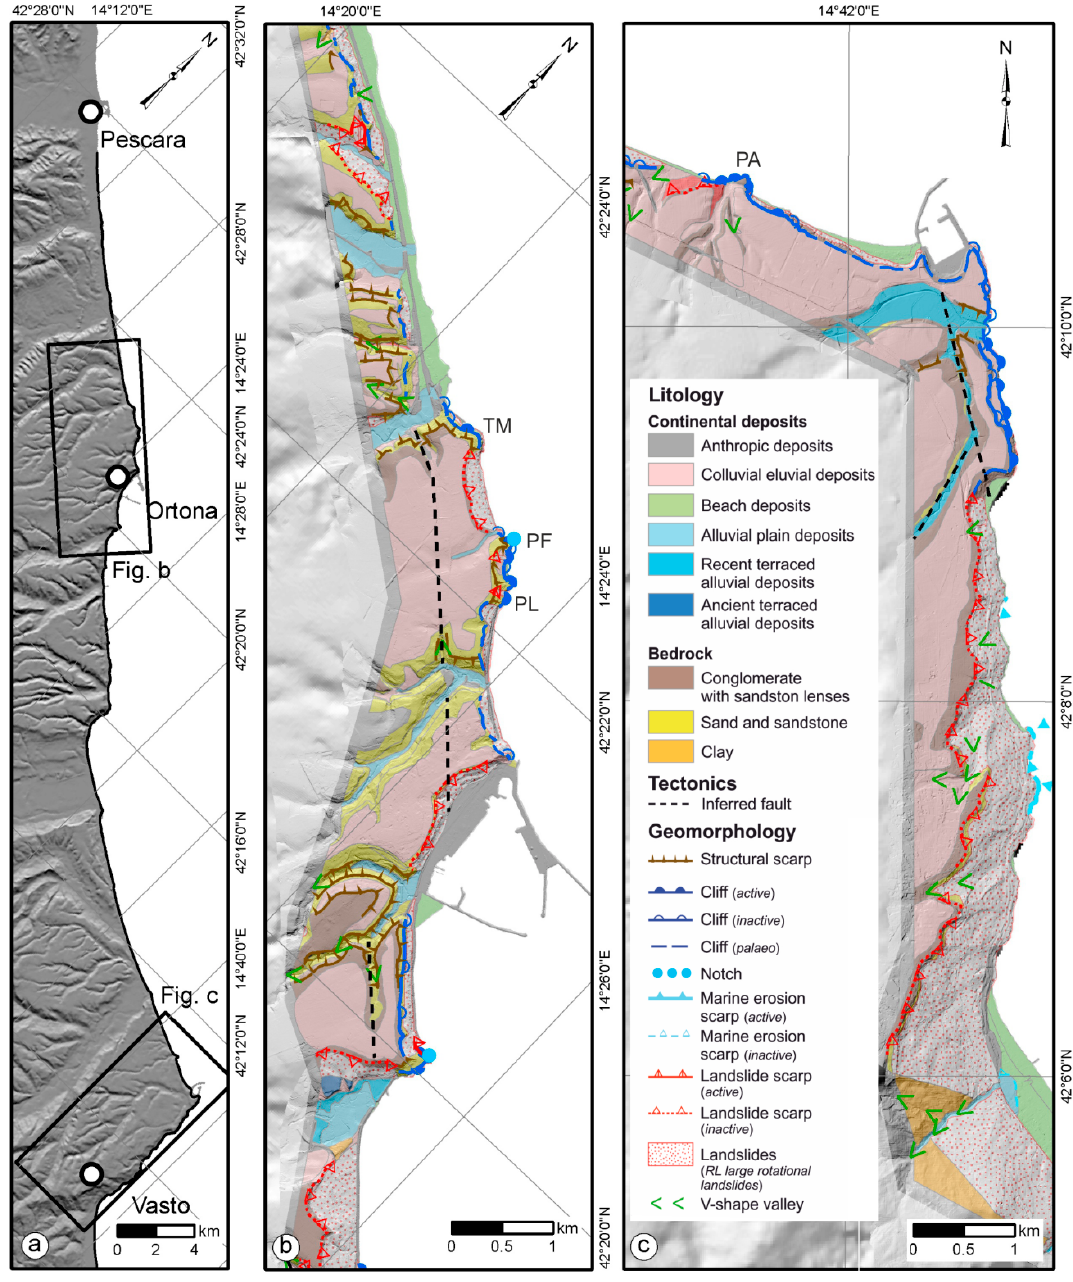
Figure 2. ( a ) Location of the studied areas; ( b ) schematic geomorphological map of the Ortona coastal sector; ( c ) schematic geomorphological map of the Vasto coastal sector (modified from Miccadei et al. [7]). Legend: TM: Torre Mucchia cliff; PF: Punta Ferruccio cliff; PL: Punta Lunga cliff; PA: Punta Aderci cliff.